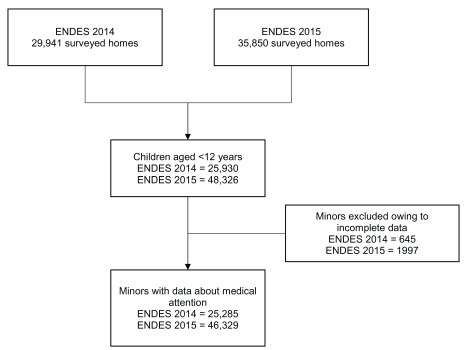
Elaboration of the selected sample for ENDES 2014–2015.The figure shows: number of surveyed homes, number of children aged <12 years, exclusions and final sample.